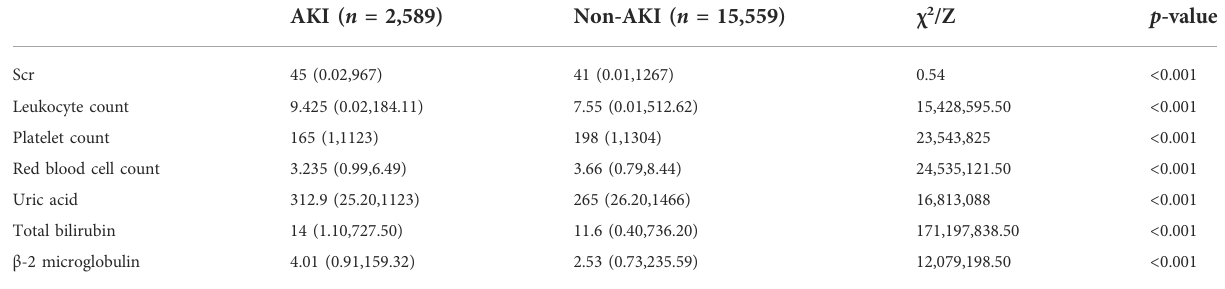
TABLE 5 Distribution of laboratory values across AKI and non-AKI.